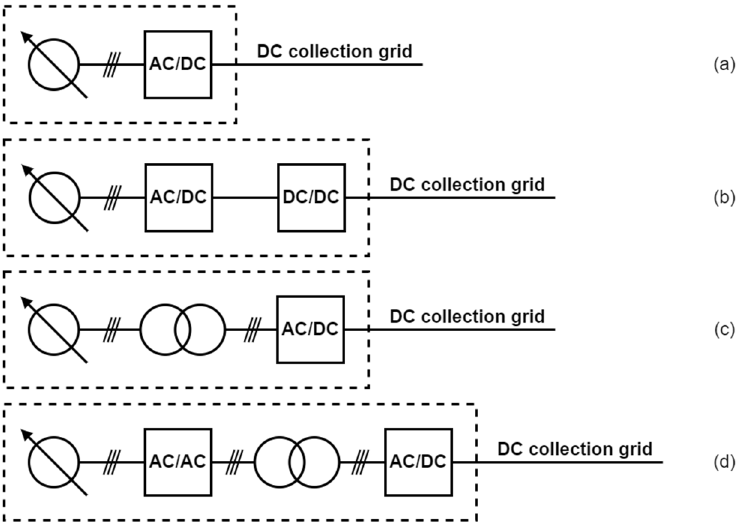
Figure 10. Concepts for AC to DC conversion in energy converters using: ( a ) only a rectifier; ( b ) a rectifier and a DC/DC converter to increase to the voltage; ( c ) a LF transformer to increase the voltage and a rectifier; ( d ) a AC/AC converter to increase the frequency of the voltage, a HF transformer to increase the voltage level and a rectifier.